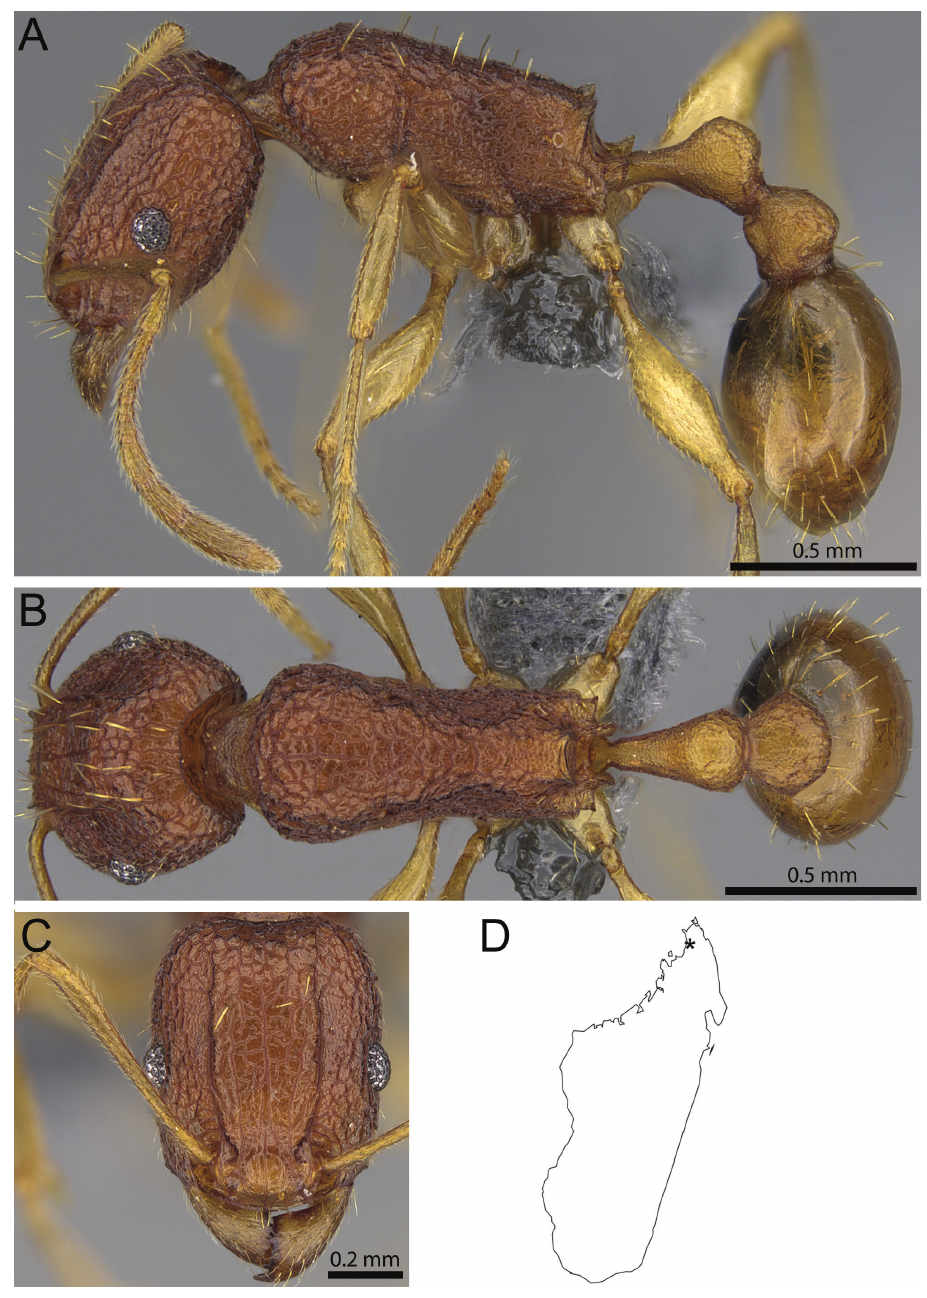
Figure 30. Tetramorium cavernicola sp. n. paratype (CASENT0373132). A Body in profile B Body in dorsal view C head in full-face view D map of Madagascar showing the type locality (black star